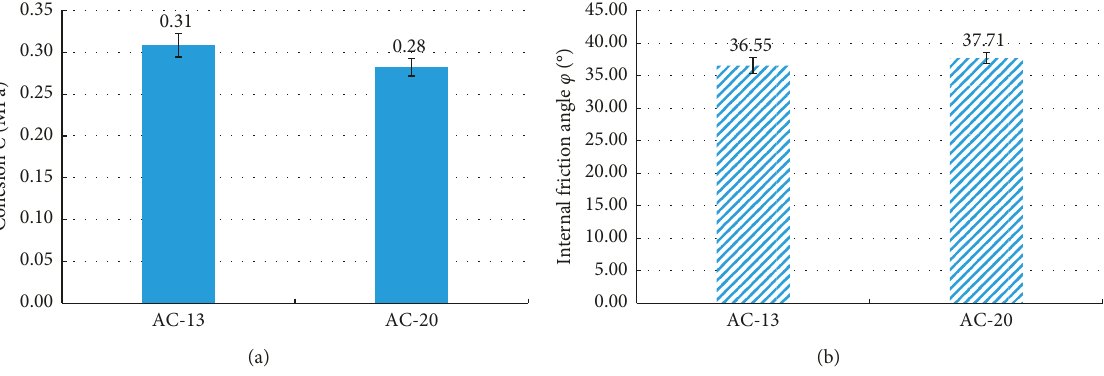
Figure 13: (a) C and (b) φ test results of asphalt mixture.